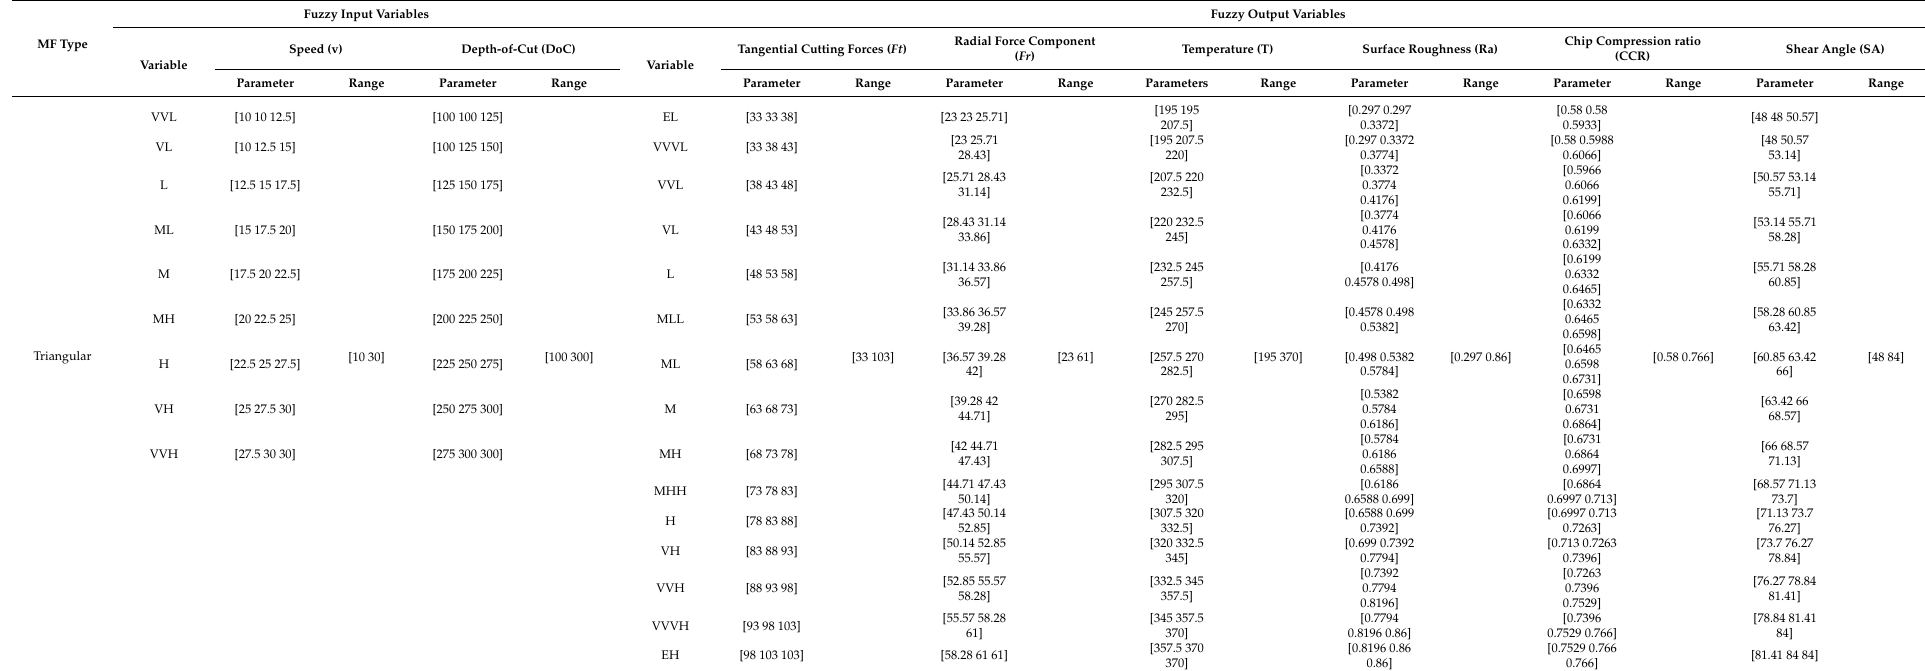
Table 2. Input and output parameters used in the CT fuzzy inference